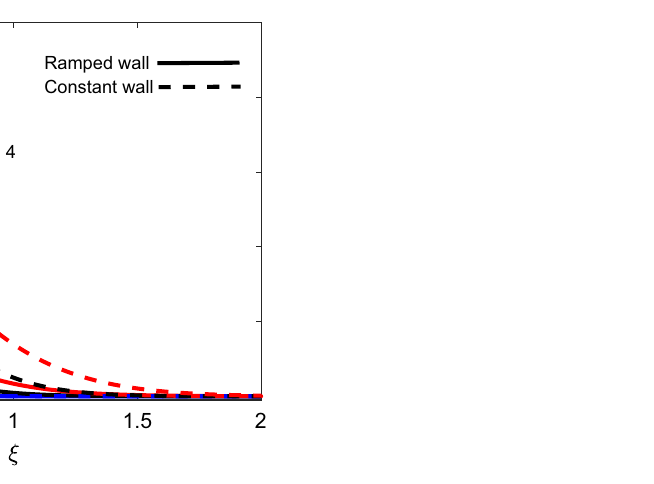
Figure 4. Energy distribution for various values of N r.